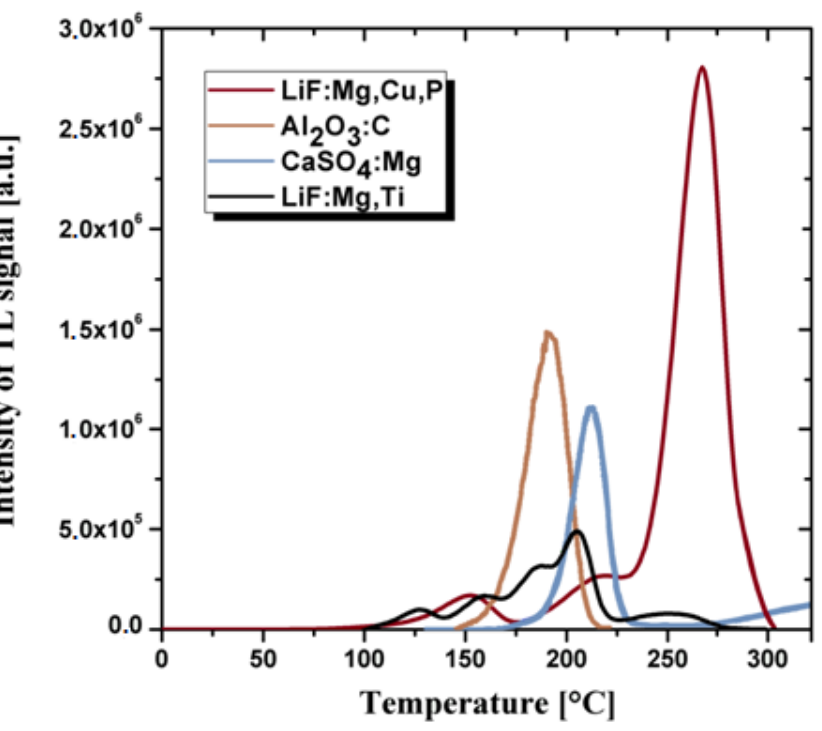
Figure 1. The comparison of the thermoluminescence glow curves for various crystalline materials used commercially as TL detectors after 10 mGy radiation dose. Data collected from the publications [38,41,42].